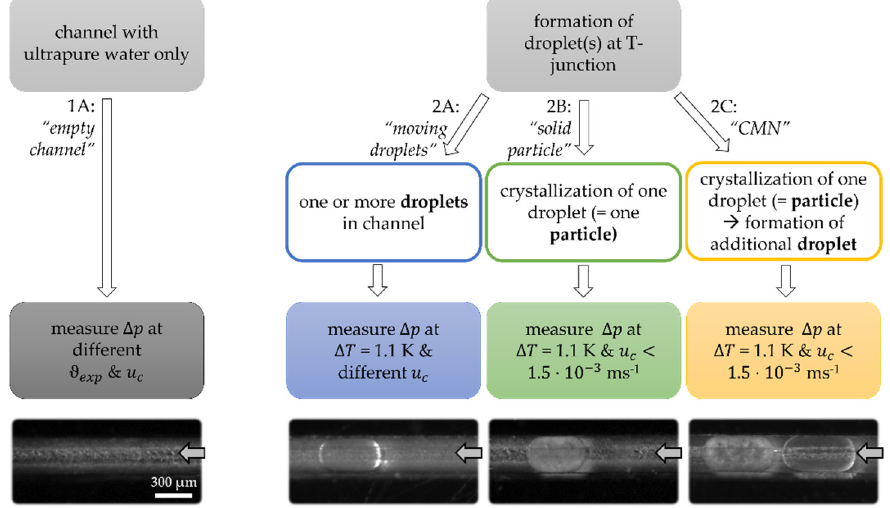
Figure 2. The experimental approach to measure the differential pressure ∆ p for the different setups: Channel filled with continuous phase only (1A, Section 3.1), liquid droplet(s) in the channel (2A, Section 3.3), solid particle partly blocking the channel (2B, Section 3.2), and during the CMN (2C, Section 3.4). u c hereby represents the velocity of the continuous phase and ∆ T the subcooling. The latter is calculated as ∆ T = ϑ m , hex − ϑ exp , with ϑ exp representing the temperature of the experiment. The arrow in the pictures indicates the direction of the flow of the continuous phase. Whereas the liquid droplet can move along the channel, the solid particle no longer changes its position, which finally enables the direct contact of the particle and the droplet at a given droplet velocity and subcooling Δ𝑇 . The continuous phase flows 1.01 to 1.1 times faster than the droplets moving through the channel.